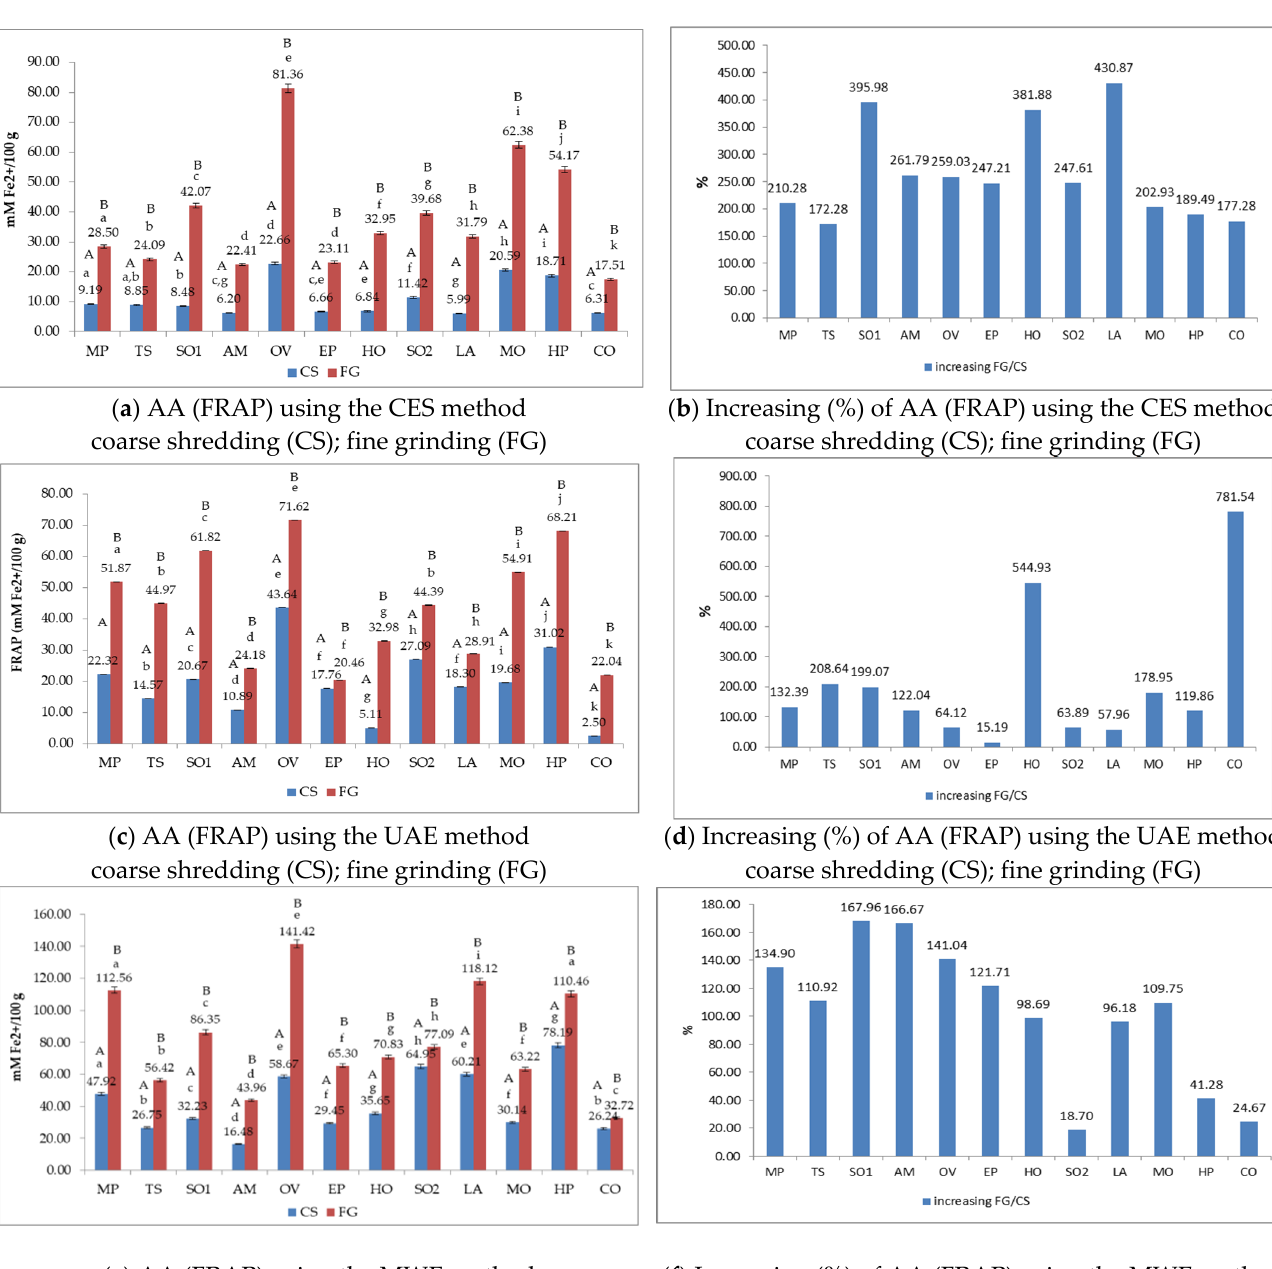
Figure 4. AA expressed as FRAP for CS/FG samples extracted by the CES, UAE, and MWE methods. According to the t − test, the different lower-case letters (a–k represent the significant differences ( p < 0.05) between samples obtained by the same shredding method. The different capital letters (A, B) represent the significant differences ( p < 0.05) between samples from the same plant obtained by different shredding methods.